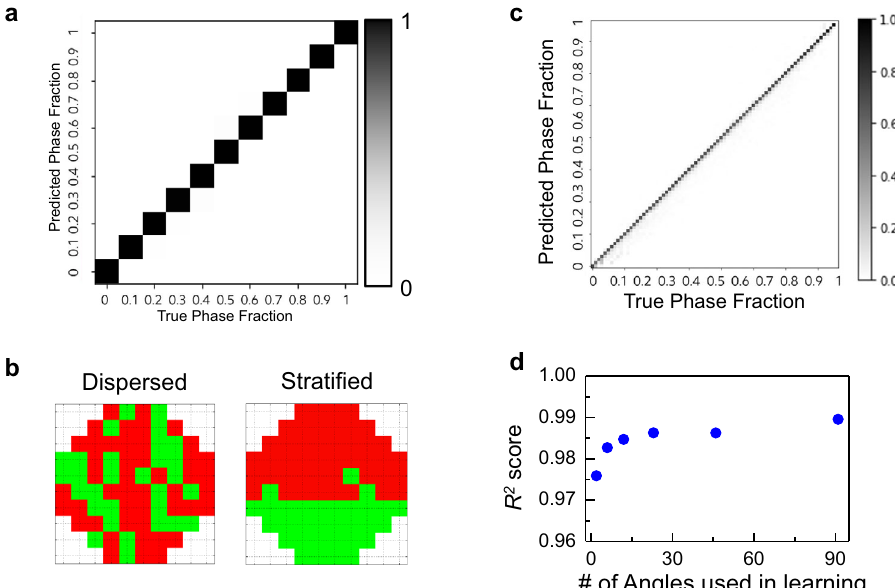
Fig. 3 Machine learning predictions with lab-scale data. a 2D probability histogram (also known as Confusion Matrix) showing the prediction accuracy for blind test data with the trained neural network model using data collected in the lab-scale experiments (e.g., Fig. 2b). The overall prediction accuracy is 99.5%. The gray-scale color bar indicates the probability of prediction along the y -axis given for each true phase fraction (step size 0.1). b Examples of a random oil- fi lling con fi guration (left) compared to a mostly strati fi ed con fi guration (right) when 40% of the holes in the photonic crystal are fi lled with oil. c 2D probability histogram showing the prediction accuracy for blind test data with the trained neural network model using simulated transmission data (e.g., Fig. 2c). The overall prediction accuracy is 68% using 8 uniformly distributed frequencies while the R 2 score is 0.990. The gray-scale color bar indicates the probability of prediction along the y -axis for each true phase fraction (step size 1.3%). d Overall prediction R 2 scores utilizing data from the number of incident angles indicated in the x -axis utilizing the machine learning training and testing procedures described in the text. The numbers of incident angles range from 2 to 91, where the angles are uniformly distributed over the range 0 –